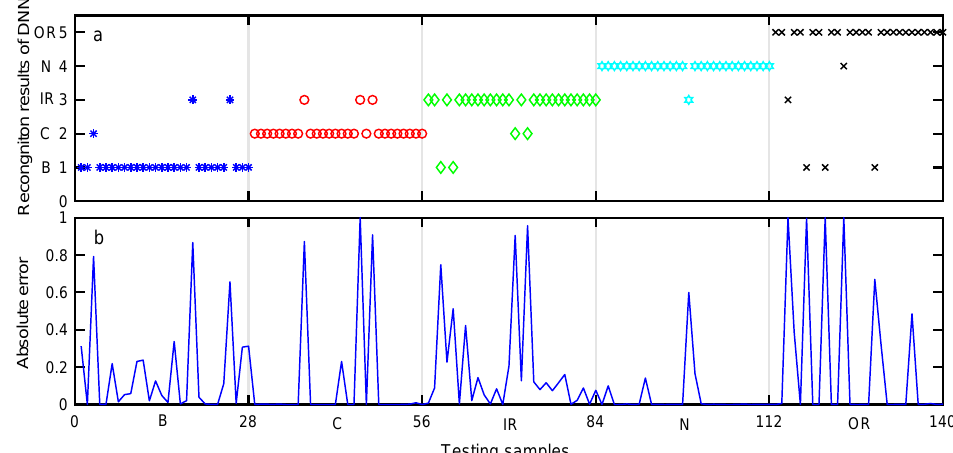
Figure 10. Preliminary diagnosis of DNN ( a ) Recognition results. ( b ) Absolute error of the proposed approach output with respect to the desired output.